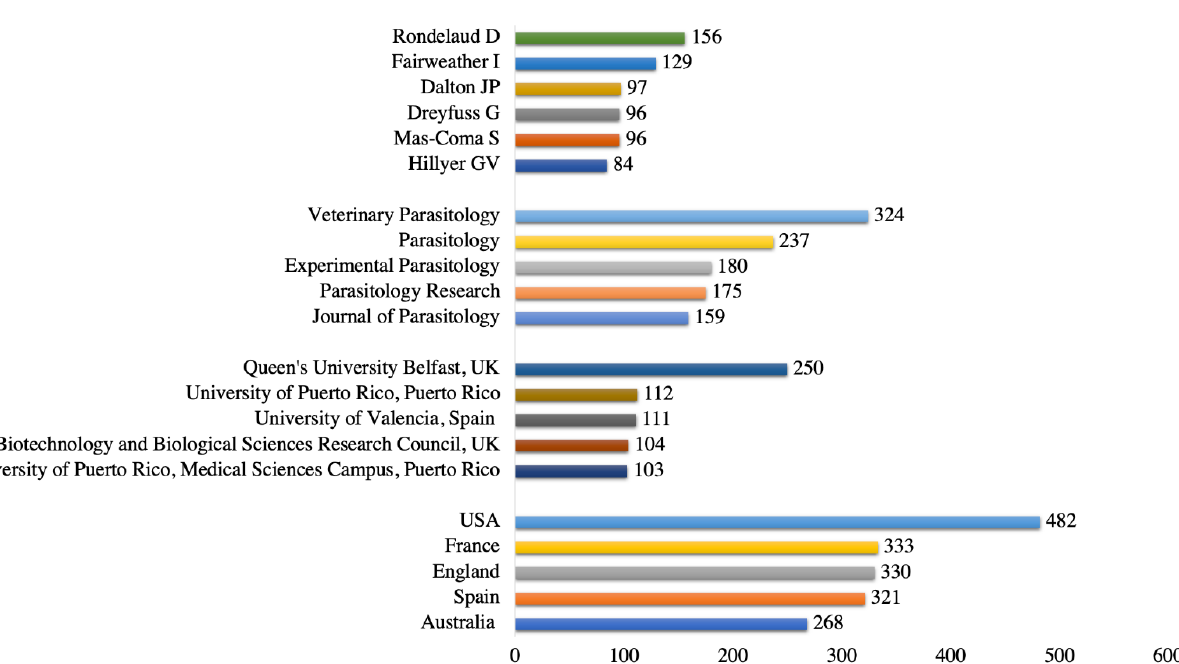
Figure 2. ( A ) Document types, ( B ) publishing languages, ( C ) top five funding agencies, ( D ) top five most-studied research areas in fascioliasis.